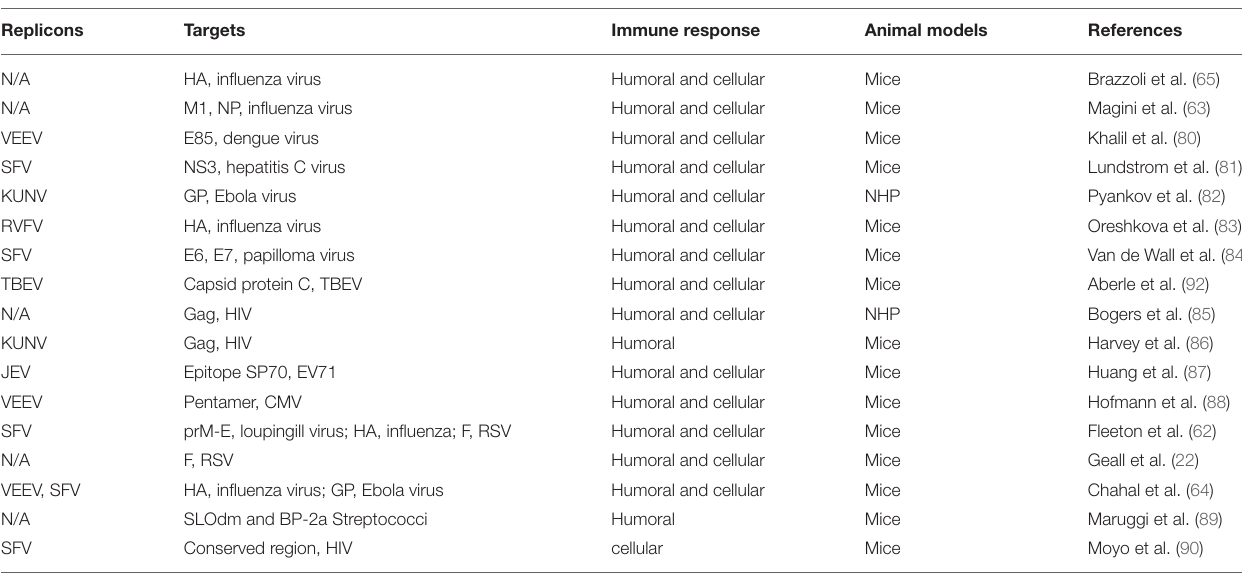
TABLE 3 | Self-amplifying mRNA vaccines against infectious